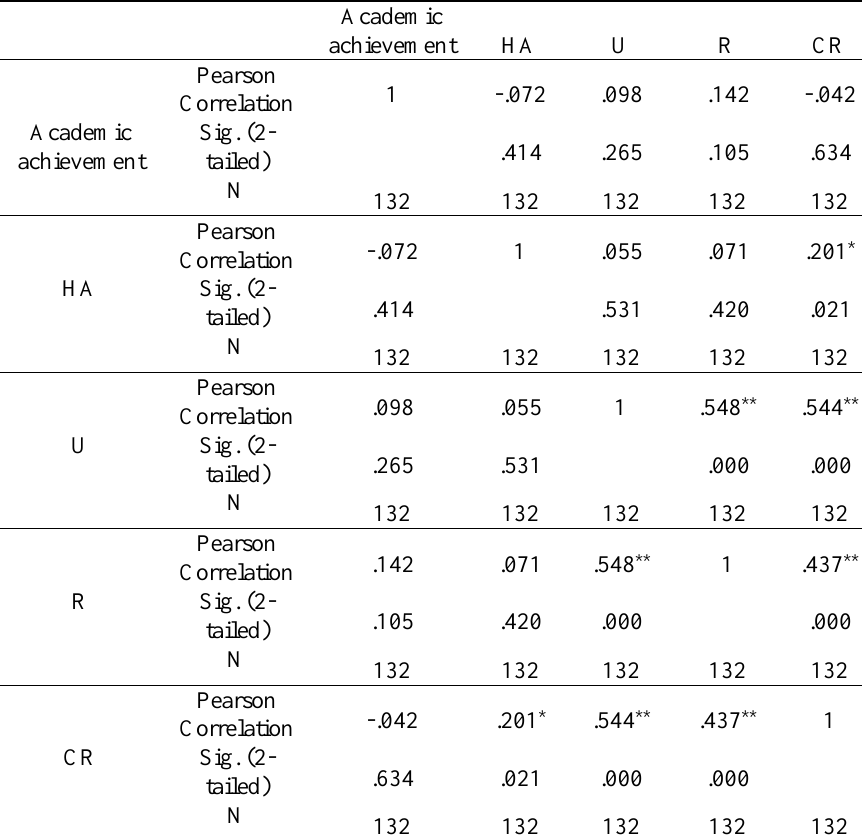
A correlation matrix investigating the relationship between different components of reflective thinking and academic